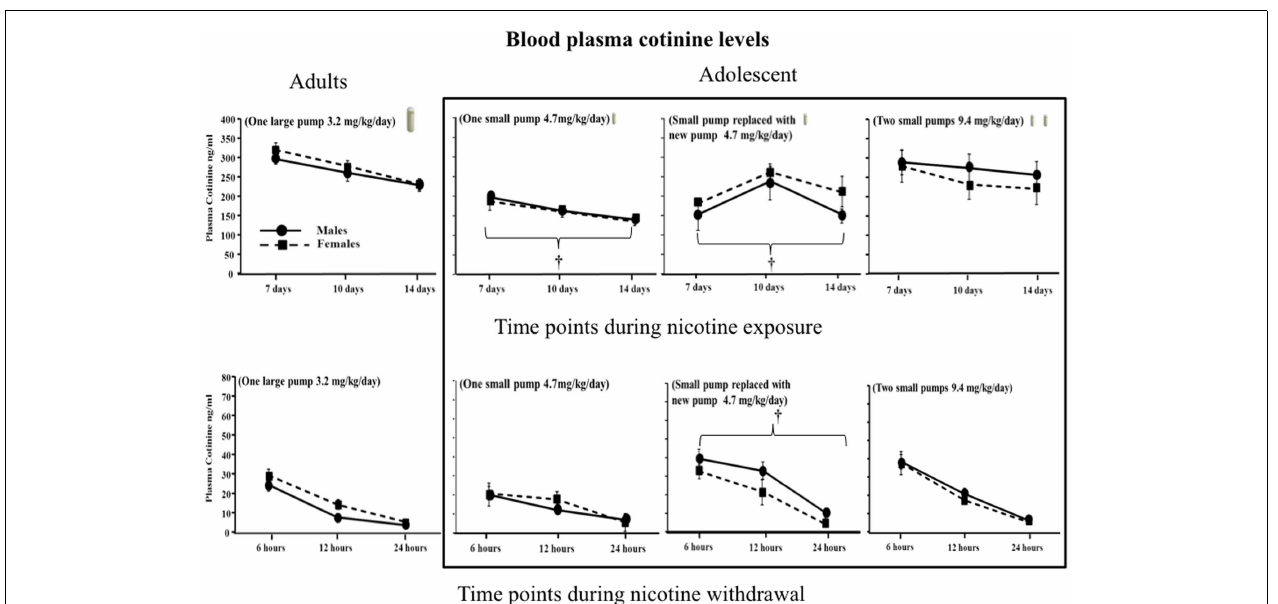
delivered: (1) a dose of 4.7mg/kg/day for 14days ( n = 17), (2) a dose of 4.7mg/kg/day that was replaced after 7days with a new pump that also delivered 4.7mg/kg/day ( n = 17), and (3) a dose of 9.4mg/kg/day that was divided in two small pumps ( n = 32).The dagger (†) denotes a significant difference across all time points between nicotine-treated adolescents and adults ( P < 0.05).